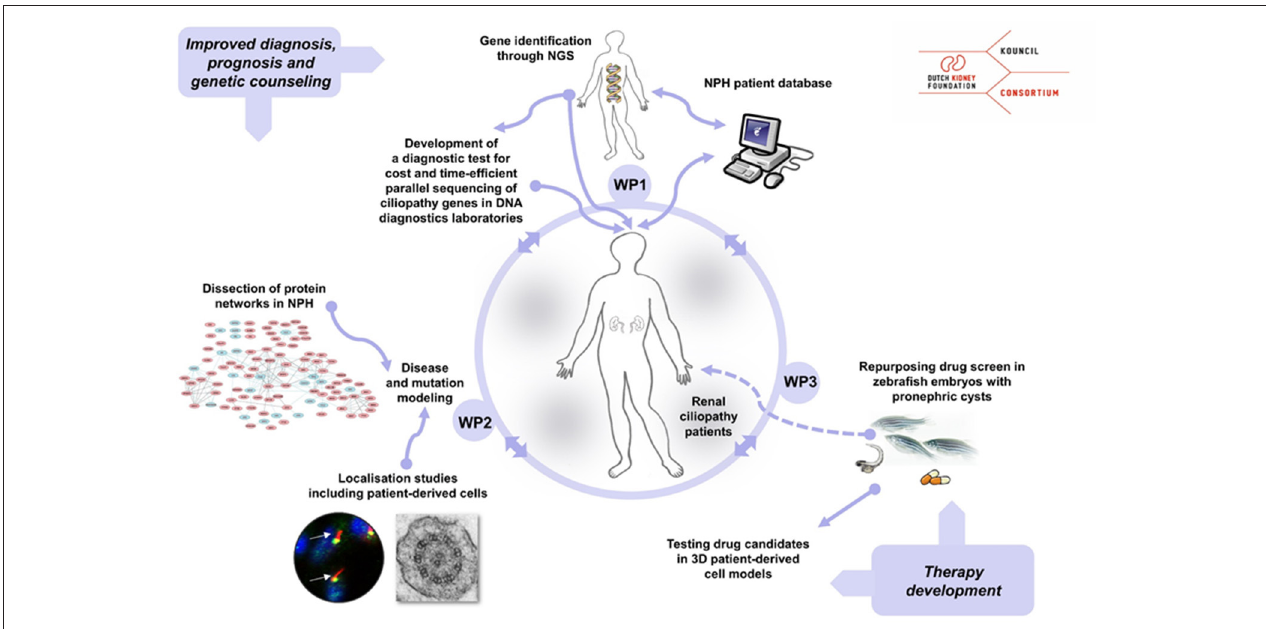
FIGURE 1 | Overview of the KOUNCIL consortium work plan that aims to improve personalized diagnostics, counseling, and treatment for nephronophthisis (NPH) patients. In work package 1 (WP1), genotypes and phenotypes were extensively studied and recorded in the nephronophthisis (NPH) database. In work package 2 (WP2), NPH protein modules were identified and NPH-related genes and gene variants were functionally characterized in vitro and in vivo . Work package 3 (WP3) focused on therapy development by drug screening in zebrafish that displayed nephric cysts. NGS; next generation sequencing.